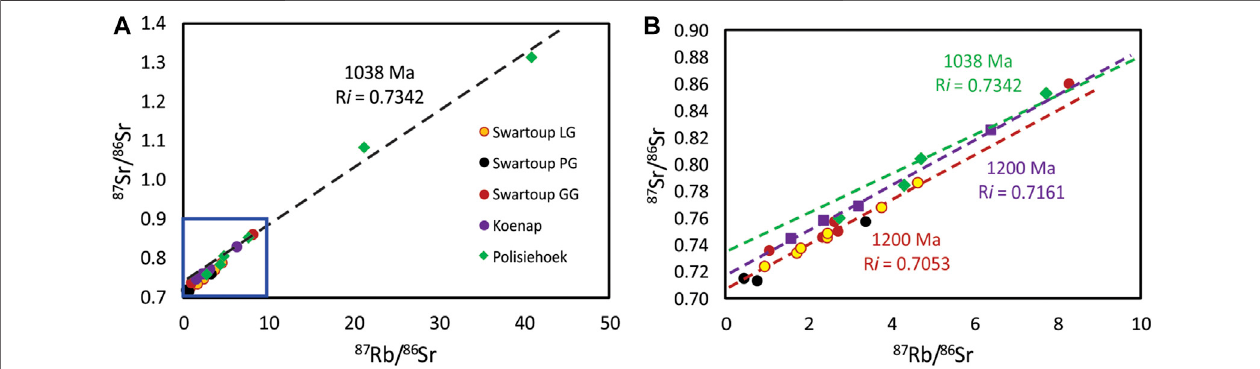
FIGURE7| Rb – Srisochrondiagramforthegranitoids. (A) AllsamplesfromthePolisiehoekgranitegneiss,extendingtohighRb/Srratiosinanear-lineararray.The lowerleftofthediagramcontainingtheSwartoupPlutonandKoenapFm.samplesisexpandedin (B) ,showingthelineararrayswithbest- fi treferencelines,withageand initial 87 Sr/ 86 Srratiosshowncorrespondingtotheirslope.ThereferencelinefortheSwartoupplutonisbasedon fi vesamplesonly.Seetextfordiscussion.SwartoupLG, PG, and GG (cid:2) leucogranitoid, pyroxene granitoid, and garnet granitoid, respectively.